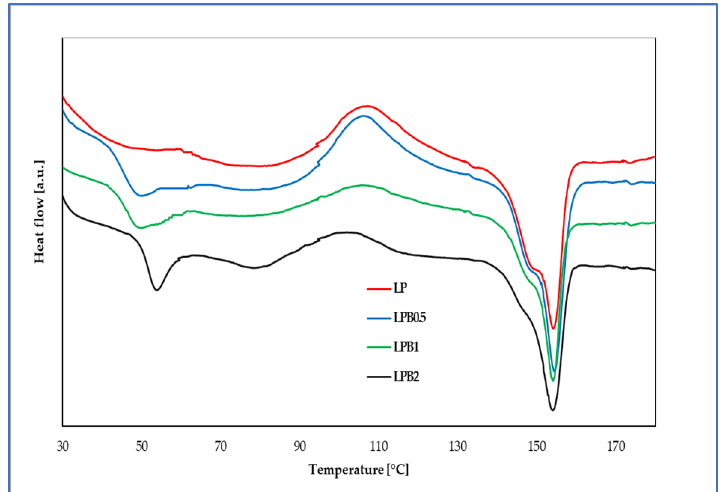
Figure 5. DSC curves of the analyzed polymeric materials.